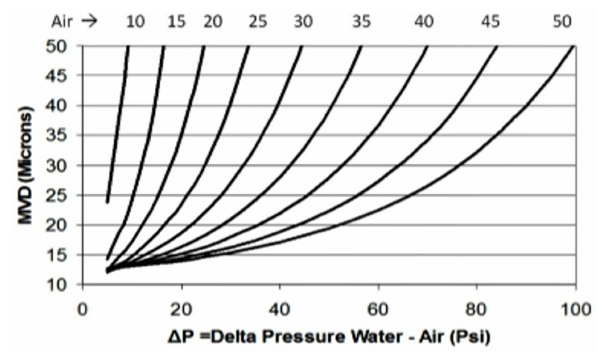
Figure 5. NASA standard icing nozzle operation chart (Ide and Oldenburg, 2001).